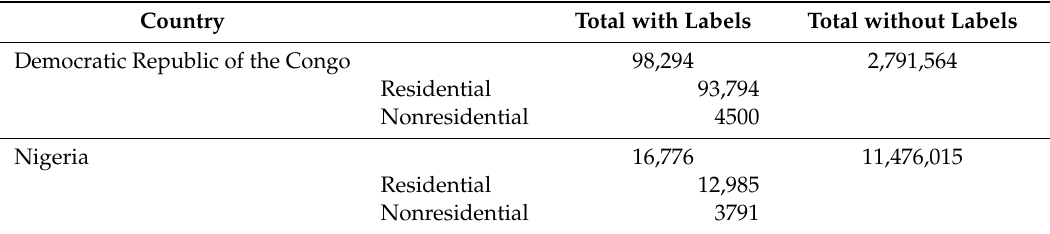
Table 2. Summary of structure data for the Democratic Republic of the Congo and Nigeria, used in building classification model training and testing.